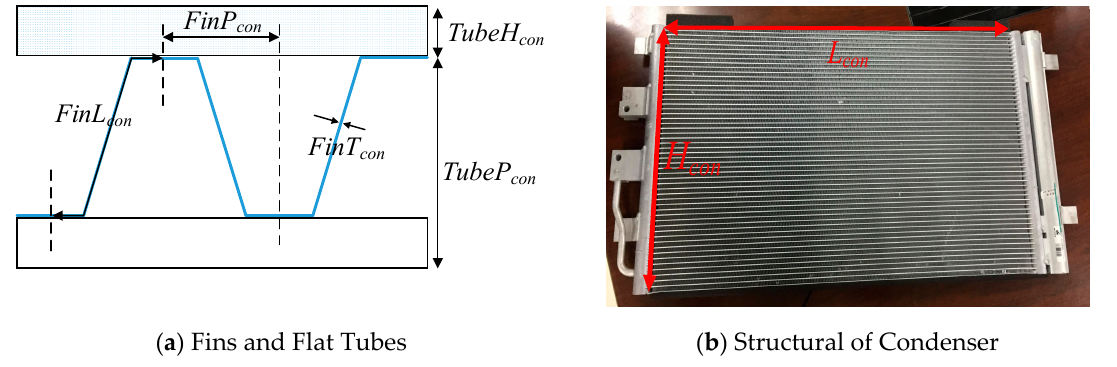
Figure 11. Structure of condenser.